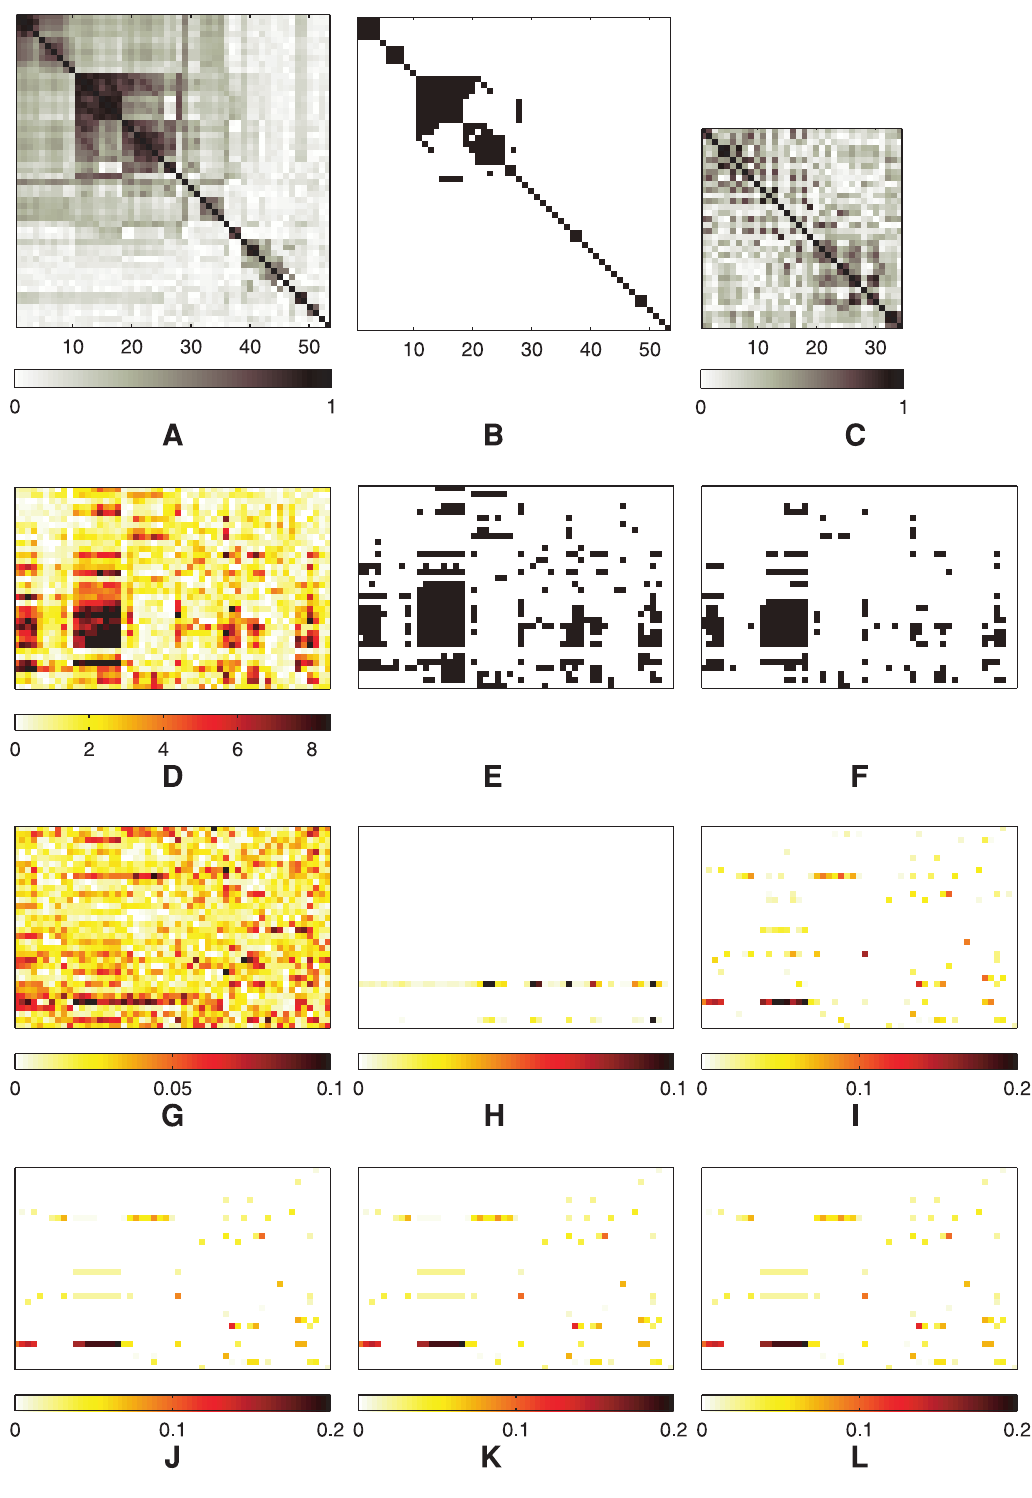
Figure 11. Results from the association analysis of the asthma dataset. (A) The correlation matrix of 53 asthma-related clinical traits. A pixel at row i and column j corresponds to the absolute magnitude of correlation between node i and j in the QTN depicted in Figure 1. (B) The trait correlation matrix thresholded at r ~ 0 : 7 . The black pixels in the lower triangular part of the matrix indicate edges between each pair of traits. (C) The matrix of r 2 s shows the linkage disequilibrium structure in the 34 SNPs in gene IL-4R . (D) { log p - value ð Þ from single-marker/single-trait association tests after 2000 permutations. (E) The SNP-trait pairs that the single-marker/single-trait analyses with permutation tests in (D) find significant at a ~ 0 : 05 are shown as black pixels. (F) The SNP-trait pairs with significant association at a ~ 0 : 01 based on the p - values in (D) are shown as black pixels. Estimated b k 0 s are shown for (G) ridge regression, (H) PCA-based regression, (I) lasso, (J) G c Flasso , (K) G 1 rows correspond to SNPs, and columns to phenotypes.